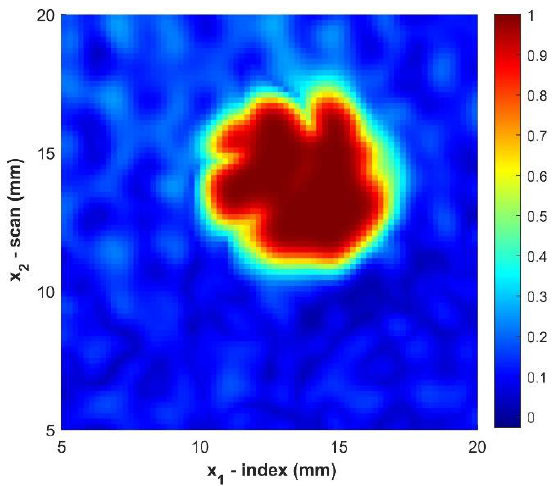
Figure 5. Visual representation of the weights of the gaussian filter with a step size of 5 and stand- ard deviation of 5/3.